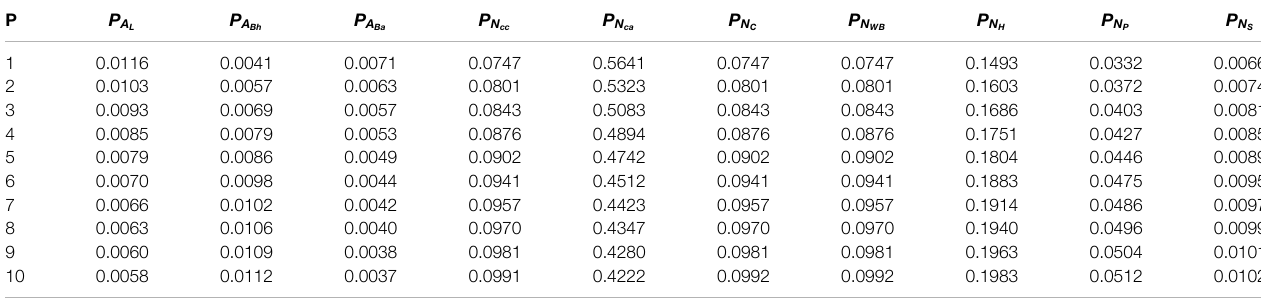
TABLE 3 | Weight parameter sets considered for the data from year 1989.